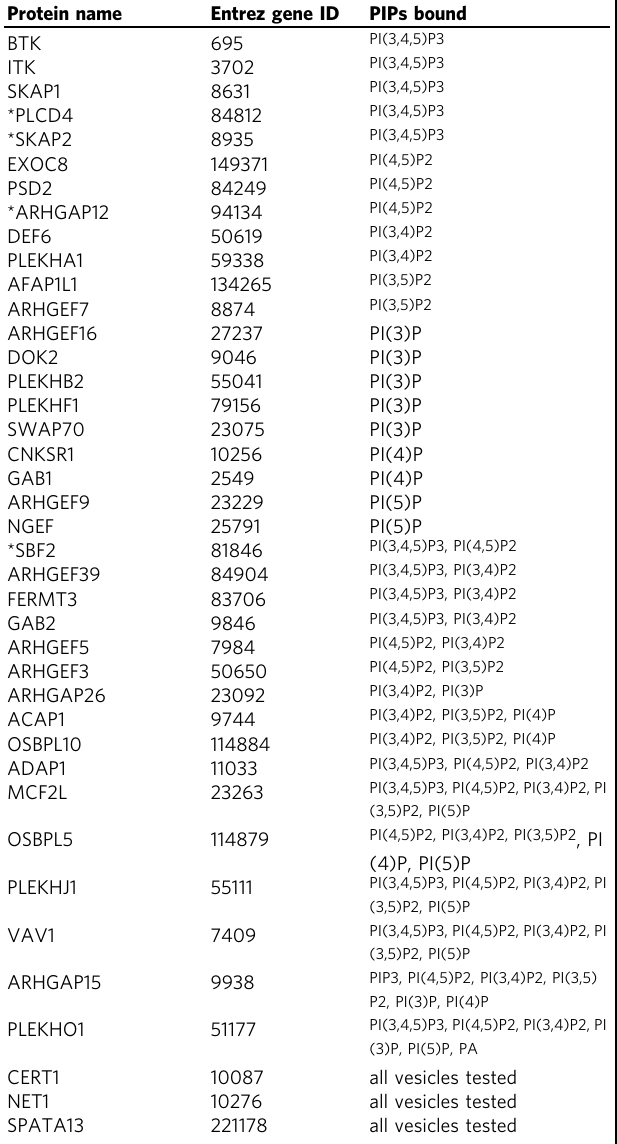
Fig. 3d, deletion of the PH domain ( Δ PH) abolished binding to both lipids. Interestingly, deletion of the N-terminal 125 amino acids ( Δ N) also abolished binding to both lipids, whereas deletion of both N- and C-termini (DH-PH) restored PI(4,5)P 2 binding but not PI(3,5)P 2 binding. On the other hand, a fragment composed of the N-terminal domain and the PH domain bound both lipids. Expression of the various ARHGEF3 fragments was con fi rmed by western blotting shown in Supplementary Fig. 4a. Taken together, our data suggest that the PH domain is necessary and suf fi cient for ARHGEF3 binding to PI(4,5)P 2 , whereas PI (3,5)P 2 binding requires the N-terminal domain in addition to the PH domain. The C-terminus appears to suppress ARHGEF3 binding to both lipids, and this suppression may be relieved by the N-terminal domain. Bacterially expressed ARHGEF3 binds PI(4,5)P 2 but not PI (3,5)P 2 . Due to overexpression of the EGFP-fusion proteins it is unlikely that any endogenous proteins in the lysate would reach stoichiometric levels to contribute directly to the observed